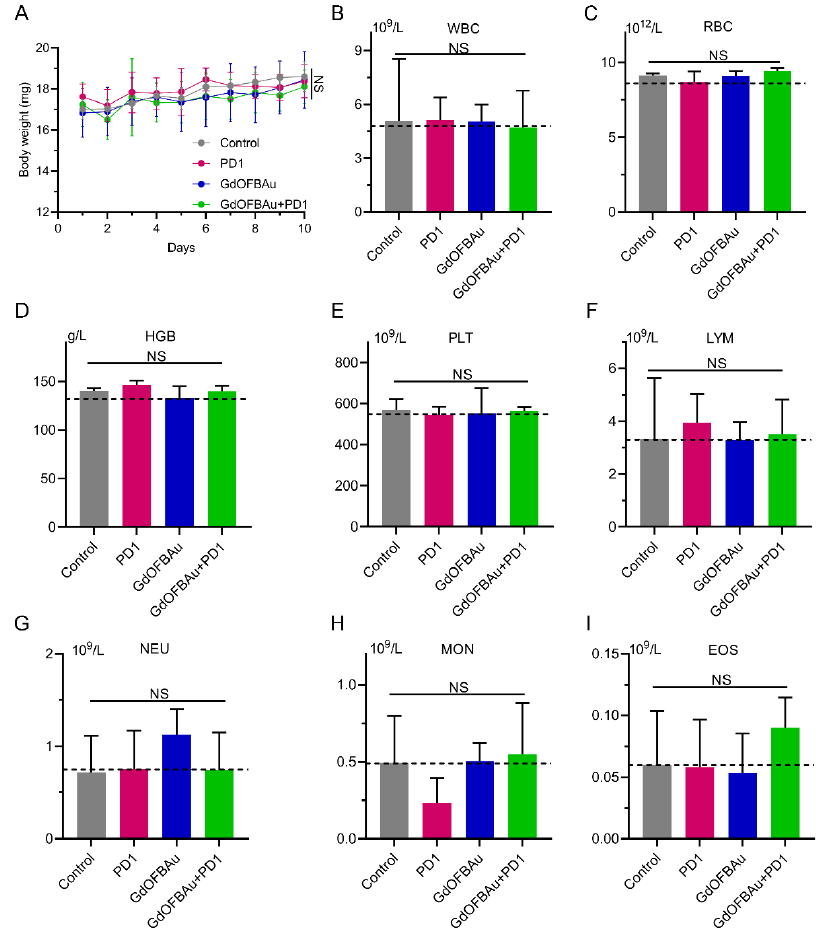
Figure 6. In vivo safety assessment of GdOFBAu. ( A ) Changes in the body weight in mice bearing MC38 during administration. ( B – I ) The indicators of blood routine cell test, including white blood cells ( B ), red blood cells ( C ), hemoglobin ( D ), platelets ( E ), lymphocytes ( F ), neutrophils ( G ), monocytes ( H ), and eosinophils ( I ).